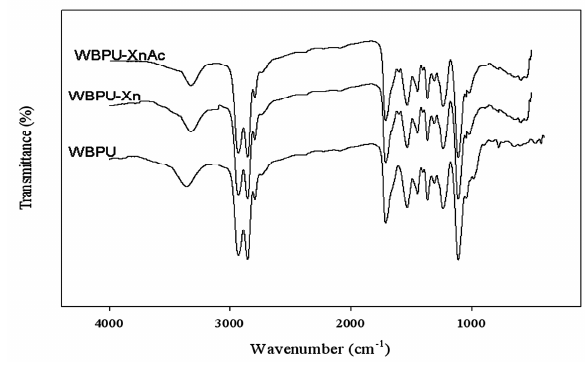
Figure 3. FT-IR spectra of WBPU, WBPU-Xn, and WBPU-XnAc coatings.